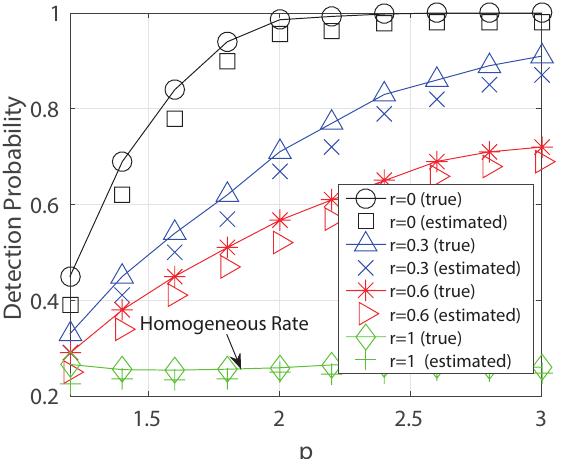
Figure 5. Detection probability by varying the parameter p for the 3-regular tree. We compare the results between true parameter p (true) and estimated parameter p (estimated) using the algorithm DPE ( K ). ( K =